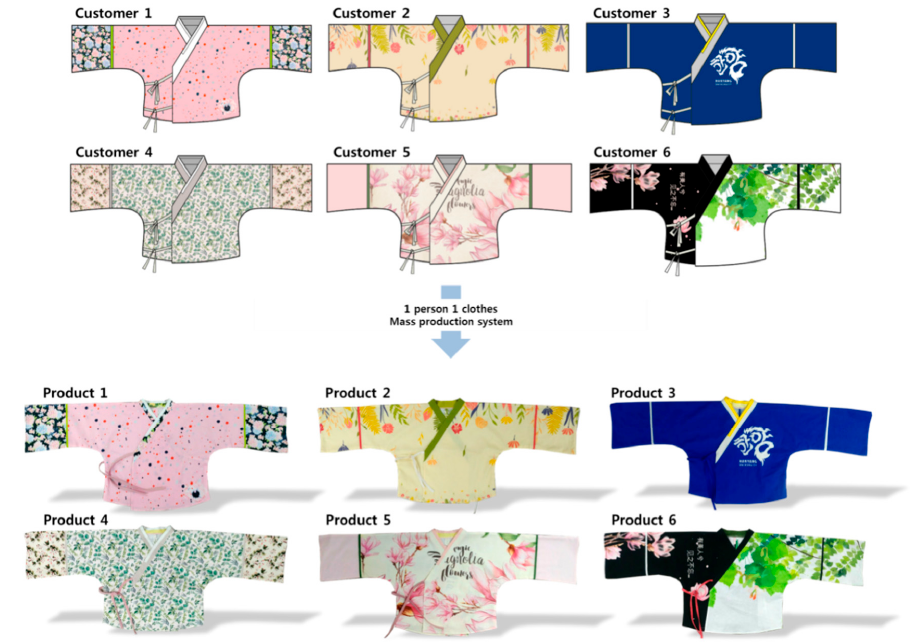
Figure 27. The product of one person one item mass production system.